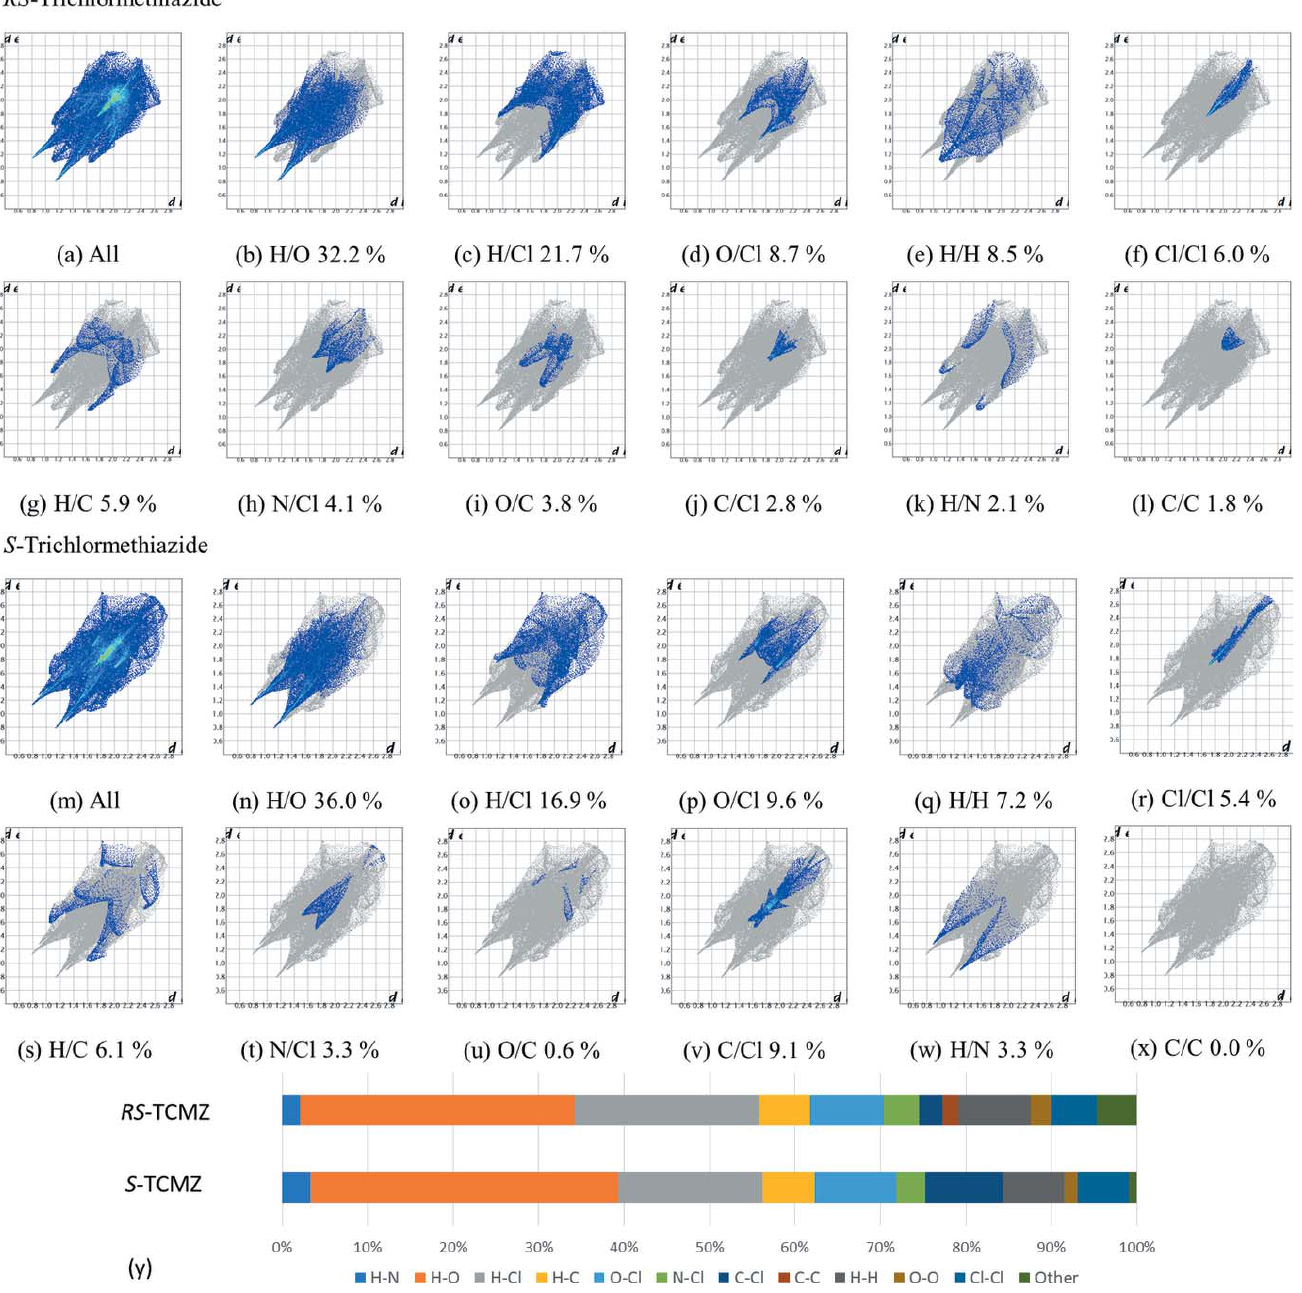
Figure 8 Fingerprint plots for RS -trichlormethiazide: ( a ) all contacts; ( b ) H (cid:2)(cid:2)(cid:2) O contacts; ( c ) H (cid:2)(cid:2)(cid:2) Cl contacts; ( d ) O (cid:2)(cid:2)(cid:2) Cl contacts; ( e ) H (cid:2)(cid:2)(cid:2) H contacts; ( f ) Cl (cid:2)(cid:2)(cid:2) Cl contacts; ( g ) H (cid:2)(cid:2)(cid:2) C contacts, ( h ) N (cid:2)(cid:2)(cid:2) Cl contacts; ( i ) O (cid:2)(cid:2)(cid:2) C contacts; ( j ) C (cid:2)(cid:2)(cid:2) Cl contacts; ( k ) H (cid:2)(cid:2)(cid:2) N contacts; ( l ) C (cid:2)(cid:2)(cid:2) C contacts. Fingerprint plots for S - Trichlormethiazide: ( m )–( x ). The percentage of surface area included is shown for each plot: RS -TCMZ 95.3% and S -TCMZ 99%. ( y ) Comparison of the contribution of intermolecular contacts (%) to the Hirshfeld surface area for RS -TCMZ and S